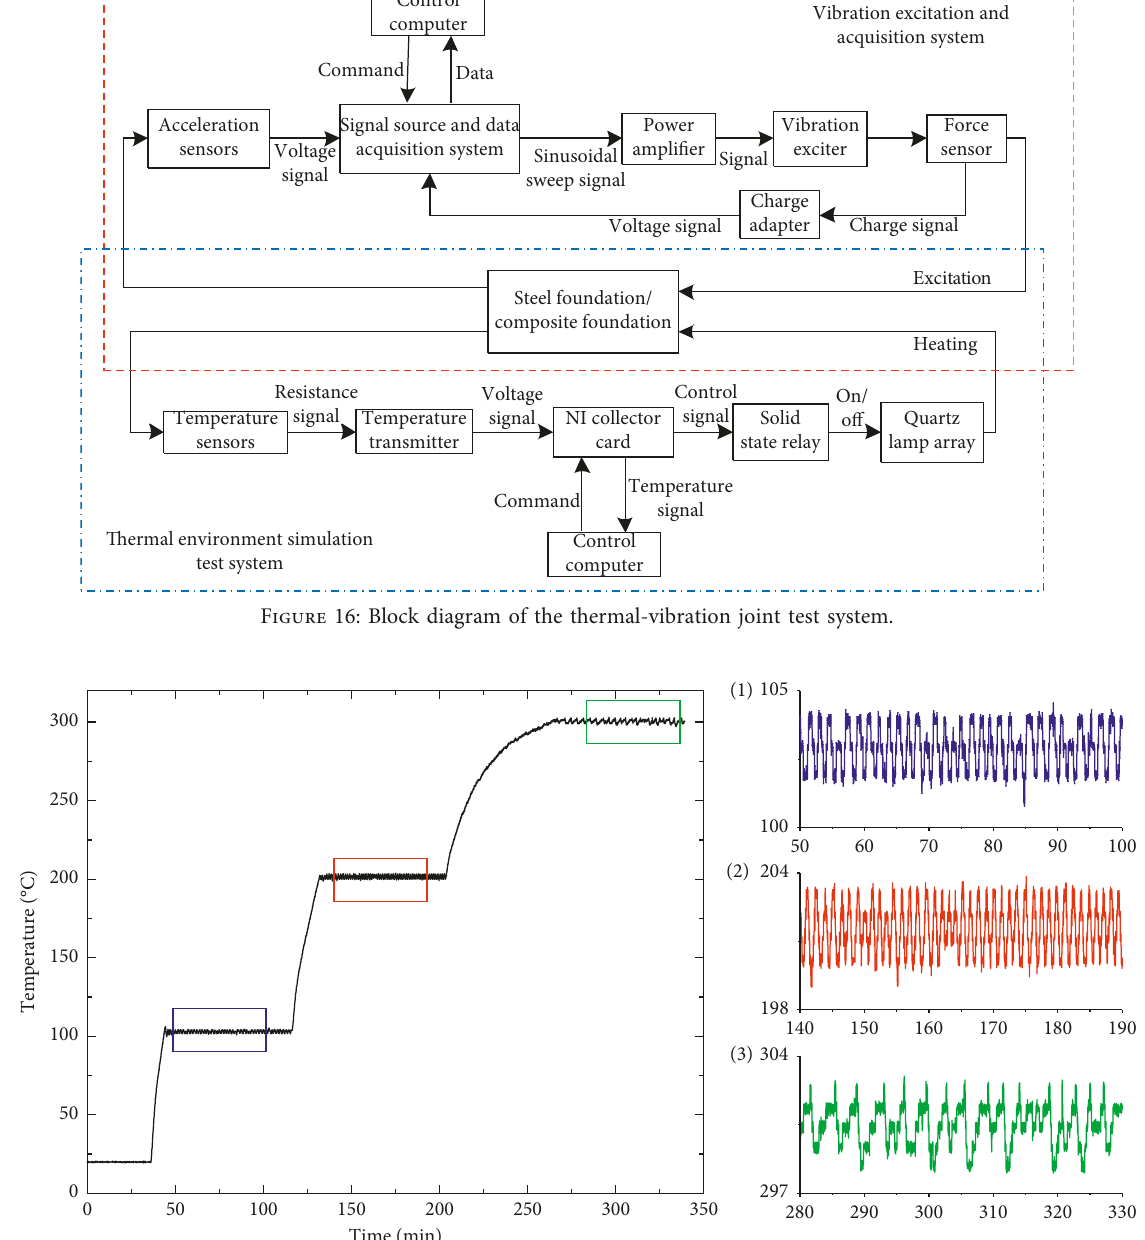
Figure 17: Preset and control temperature on the web